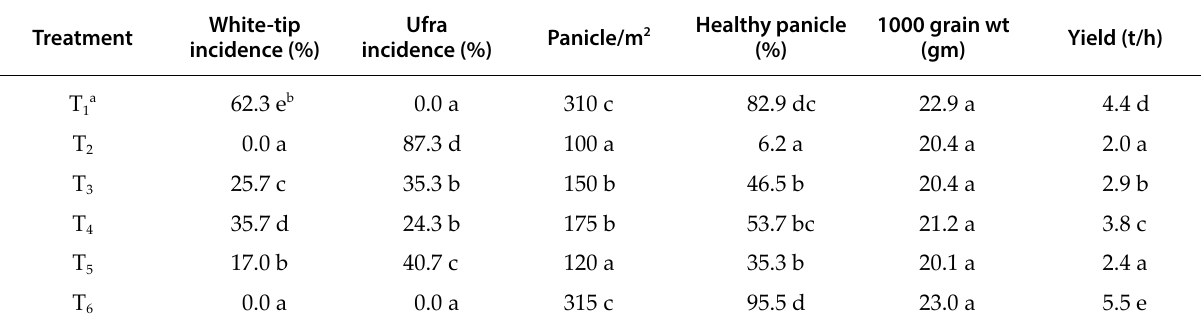
Table 3B. Mean disease incidence, yield components and yield of rice plants inoculated with different ratios of Aphenchoides besseyi and Ditylenchus angustus in the field